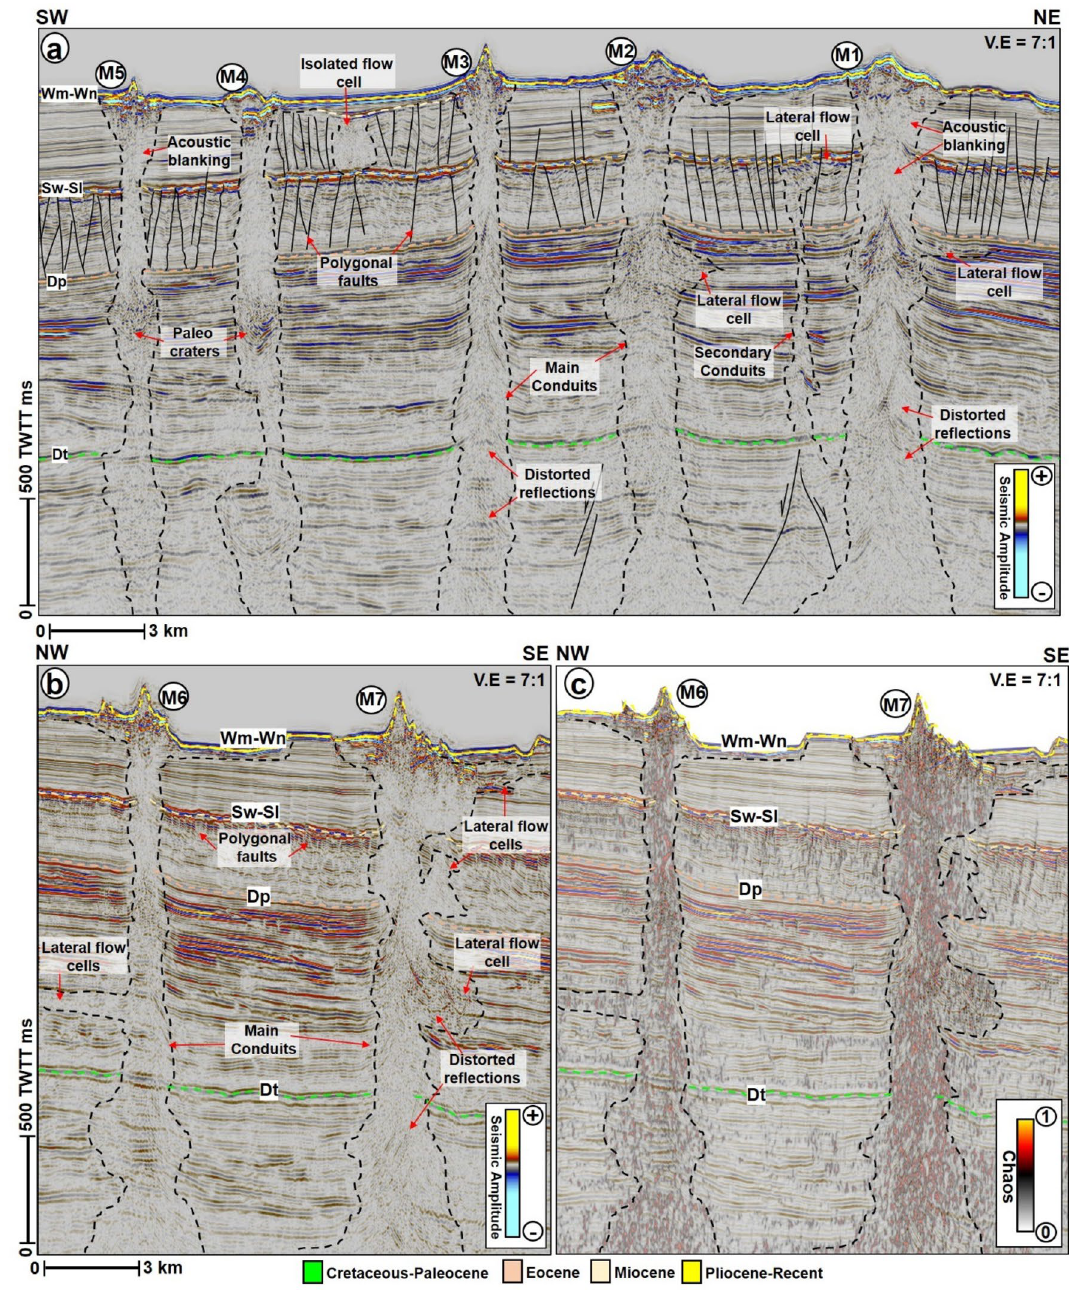
Figure 5. SW-NE seismic profile across mounds M1 to M5. The mounds are connected to the basement by vertical zones of distorted seismic signal interpreted as fluid escape pipes. Average height of the pipes is about 4500 ms TWTT. ( b ) and ( c ) NW–SE seismic profiles showing vertical conduits associated with mounds M6 and M7. In ( c ), the chaos seismic profile is overlain by the amplitude sections to correctly map the outline of the pipes. A striking feature of these pipes is that they are connected in their middle parts to lateral zones of chaotic reflections, interpreted as flow cells. TWTT: Two-way travel time in milliseconds. The uninterpreted seismic sections are provided in the supplementary document